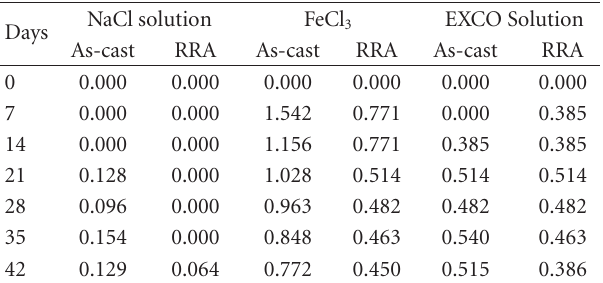
Table 2: Gravimetric corrosion rate (mm/yr) for the 0.42% Mg specimen.